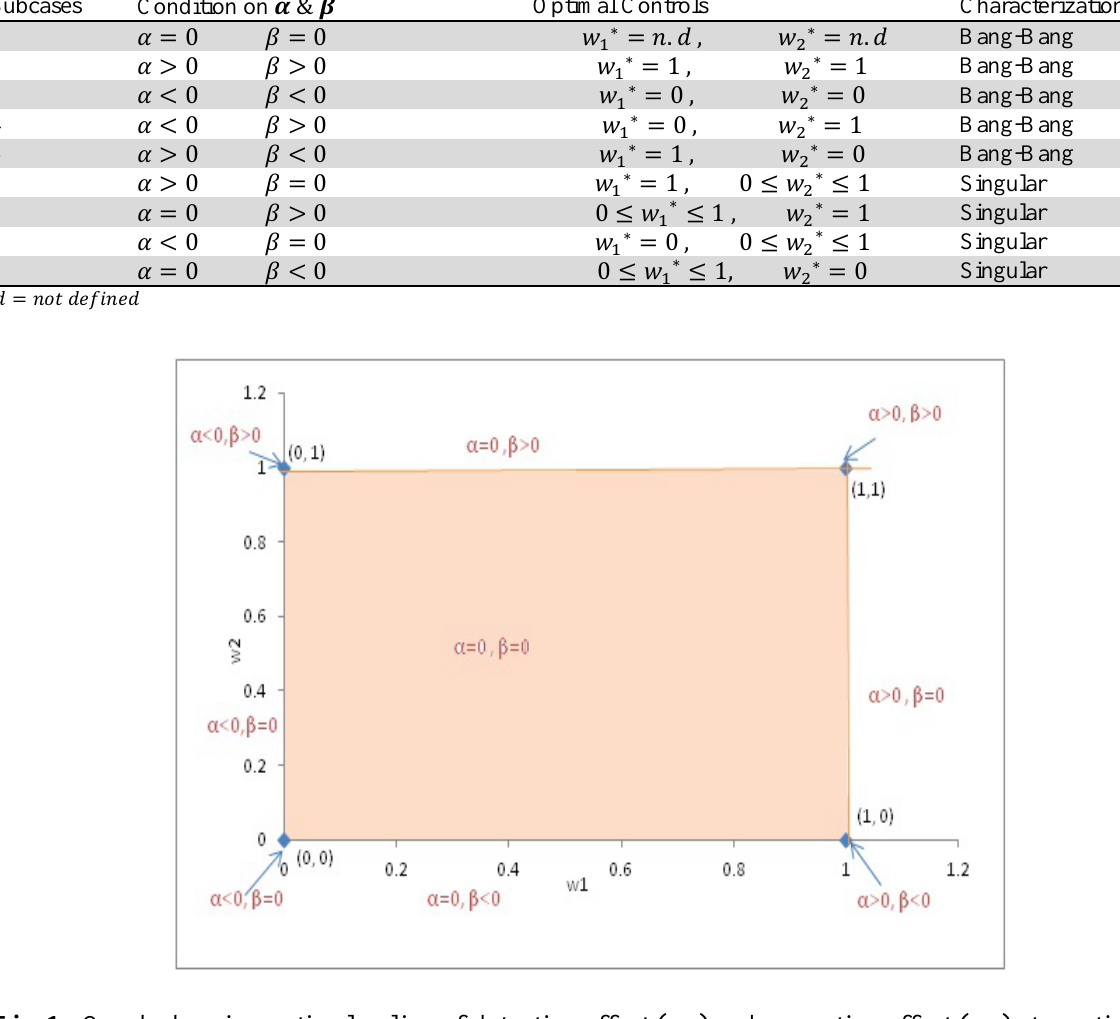
Fig. 1 . Graph showing optimal policy of detection effort (